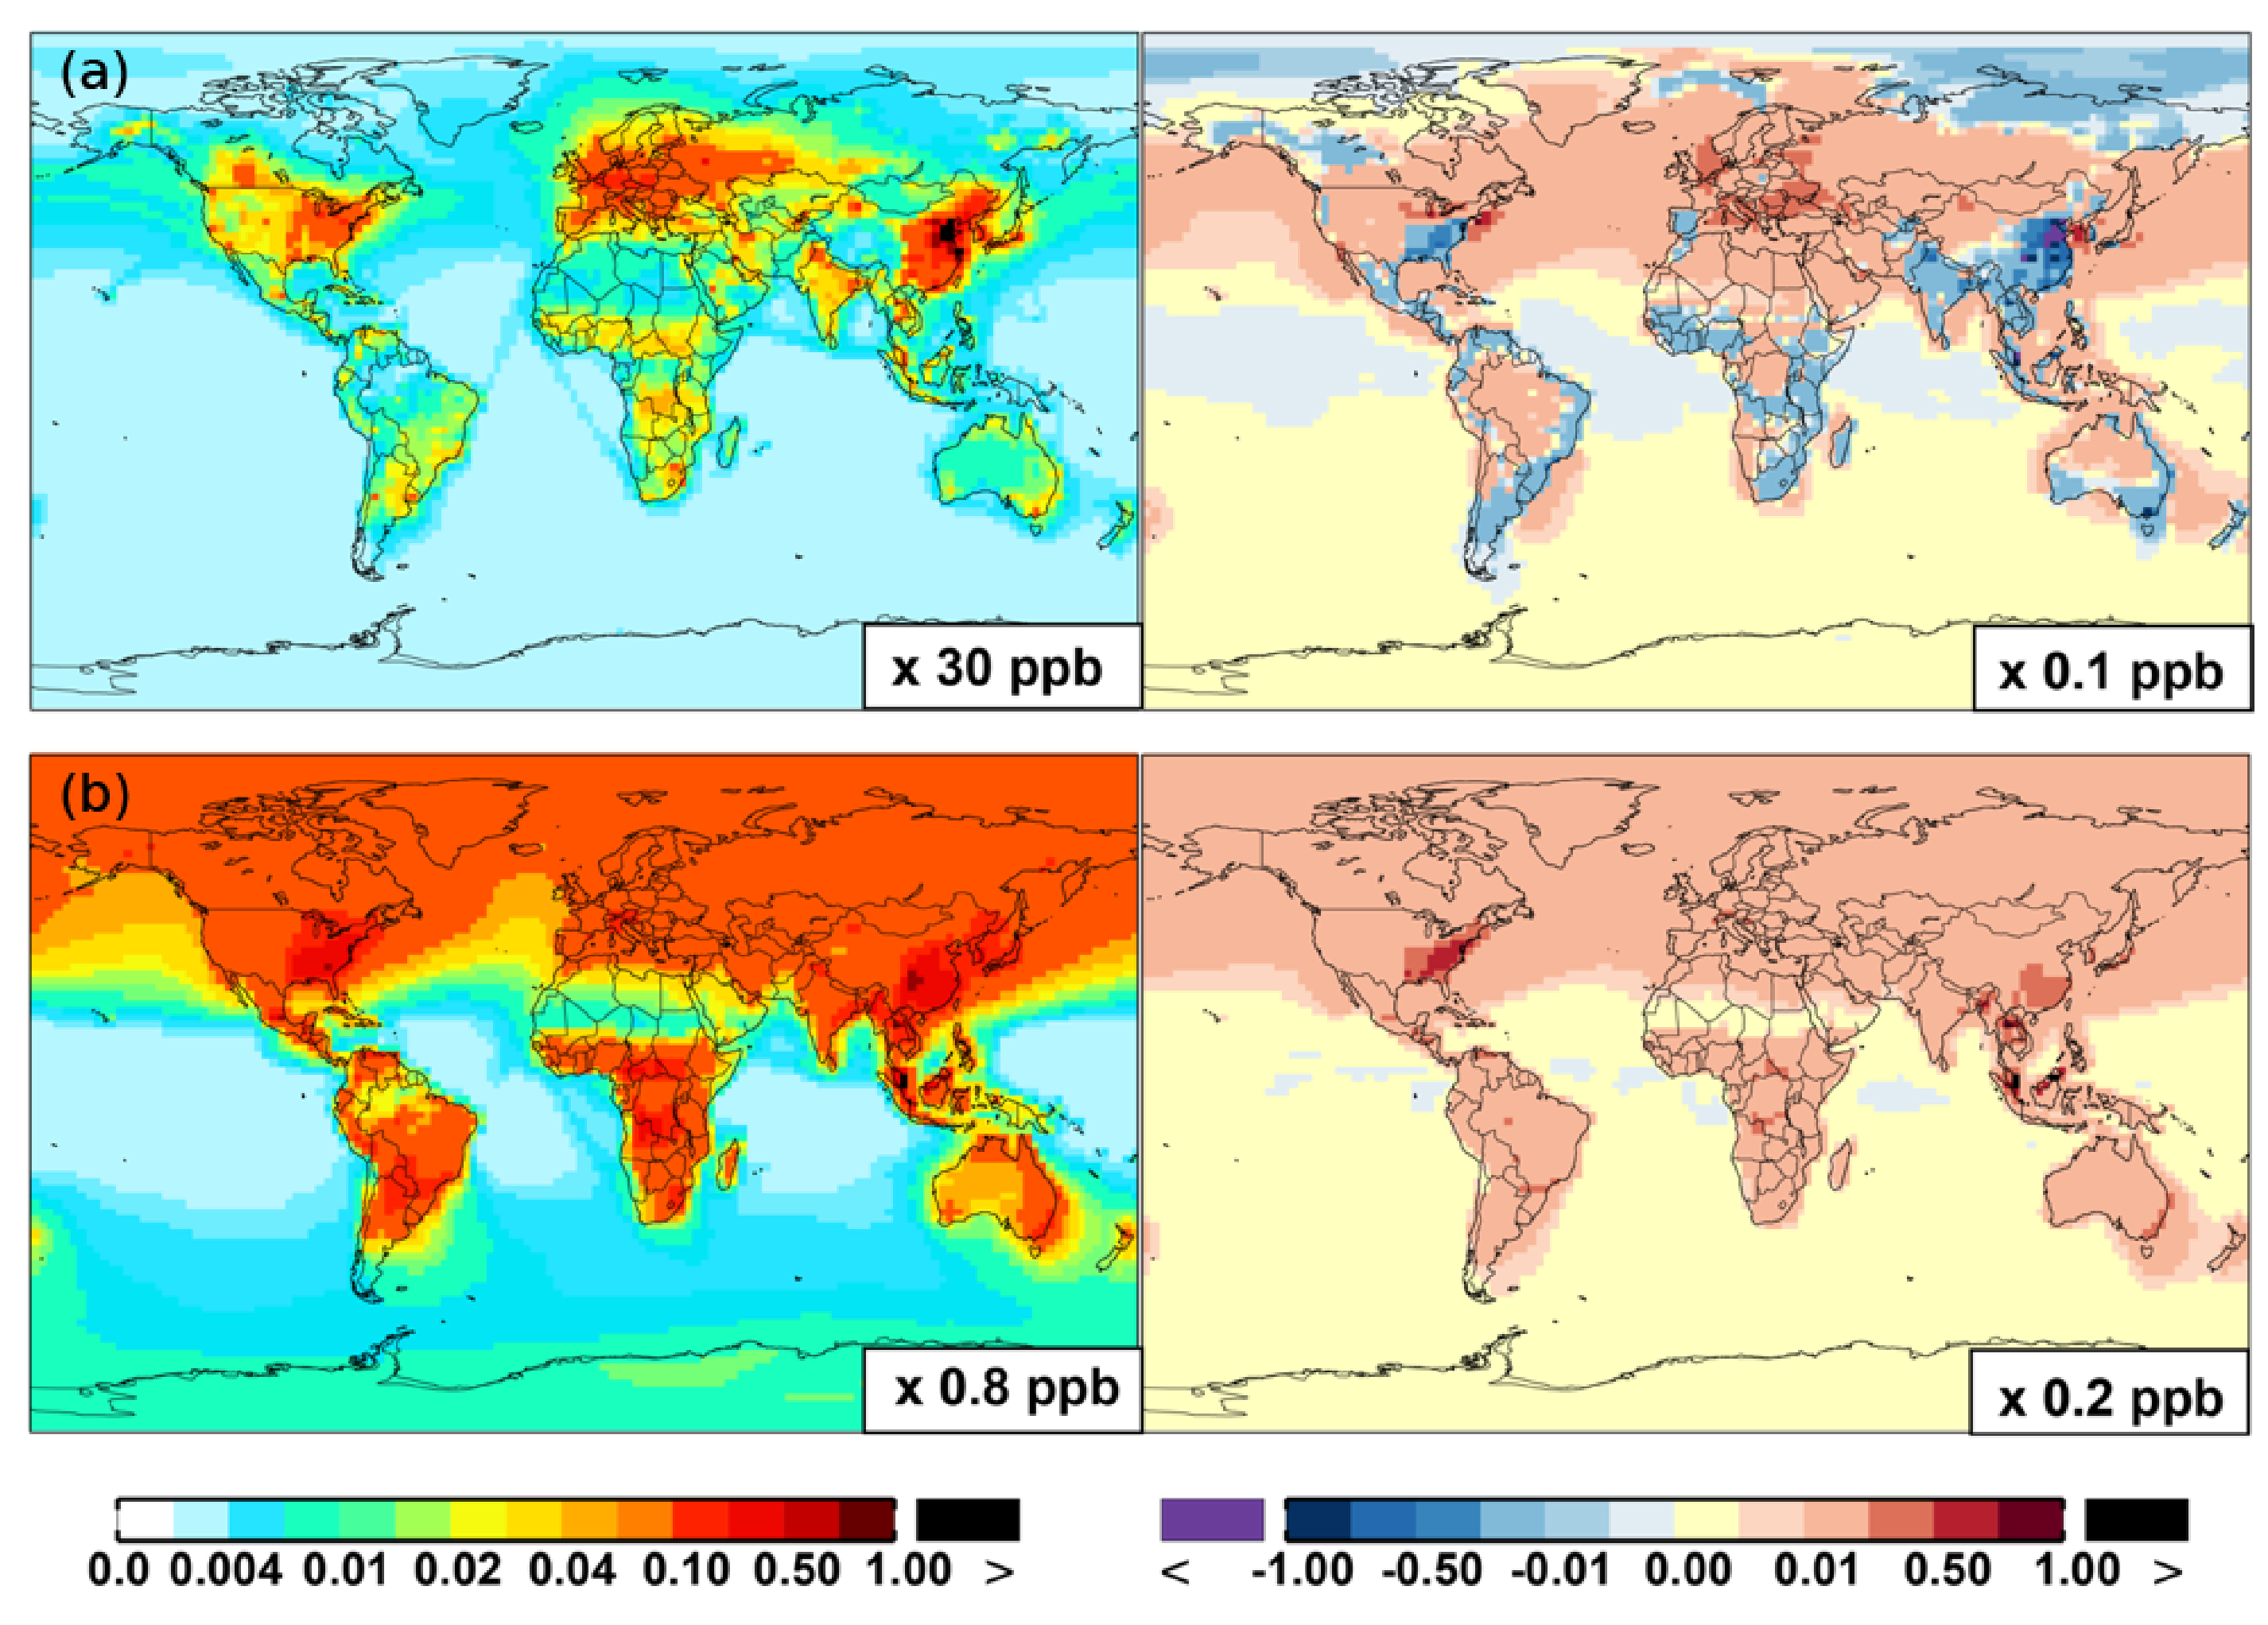
Same as Fig. 6 but for NOx
(a) and PAN (b).